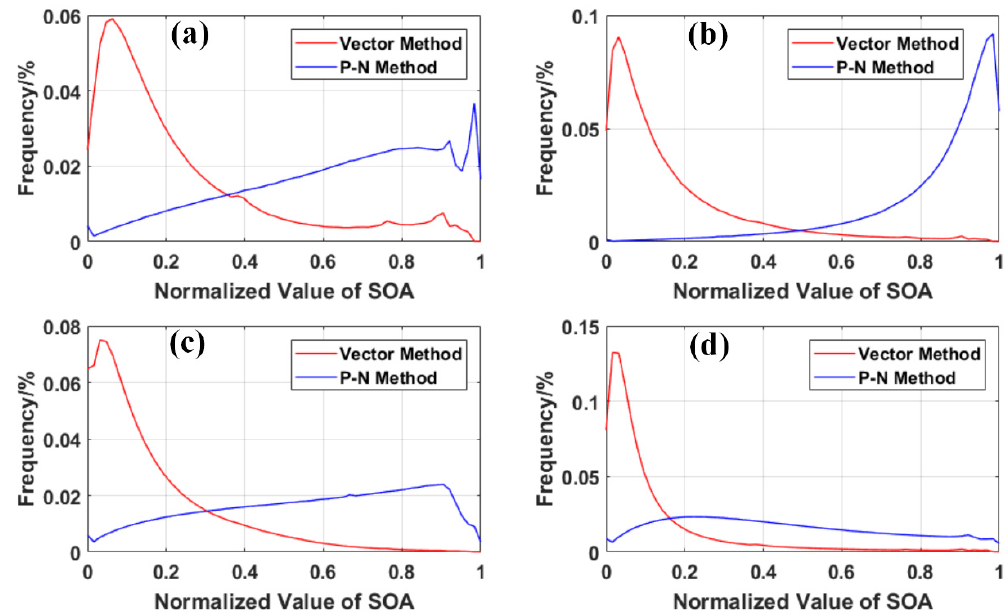
Figure 9. Frequency distribution of SoA using different methods in different areas. ( a ) Suide TA1, ( b ) Suide TA2, ( c ) Mount Lu, and ( d ) Dahua.